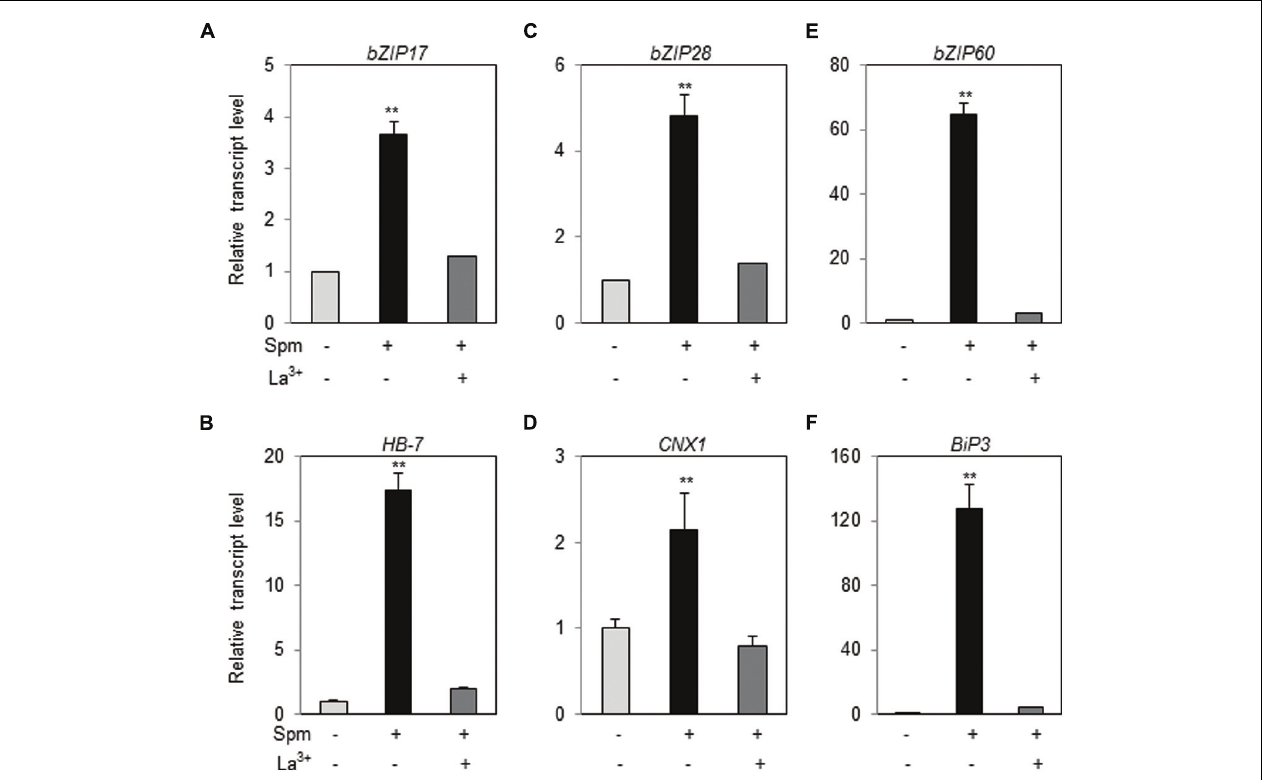
FIGURE 6 | Ca 2 + -channel blocker alleviates the UPR induction by Spm. qRT-PCR was performed using the cDNAs prepared from control-, Spm-treated, and Spm and La 3 + -co-treated Arabidopsis seedlings. (A) bZIP17 ; (B) HB-7 ; (C) bZIP28 ; (D) CNX1 ; (E) bZIP60 ; (F) Bip3 . The transcript level in control Arabidopsis plant was set as 1 and relatively displayed. Values are mean ( ± SD) from three independent experiments. Asterisks indicate significant difference ( ∗∗ P <